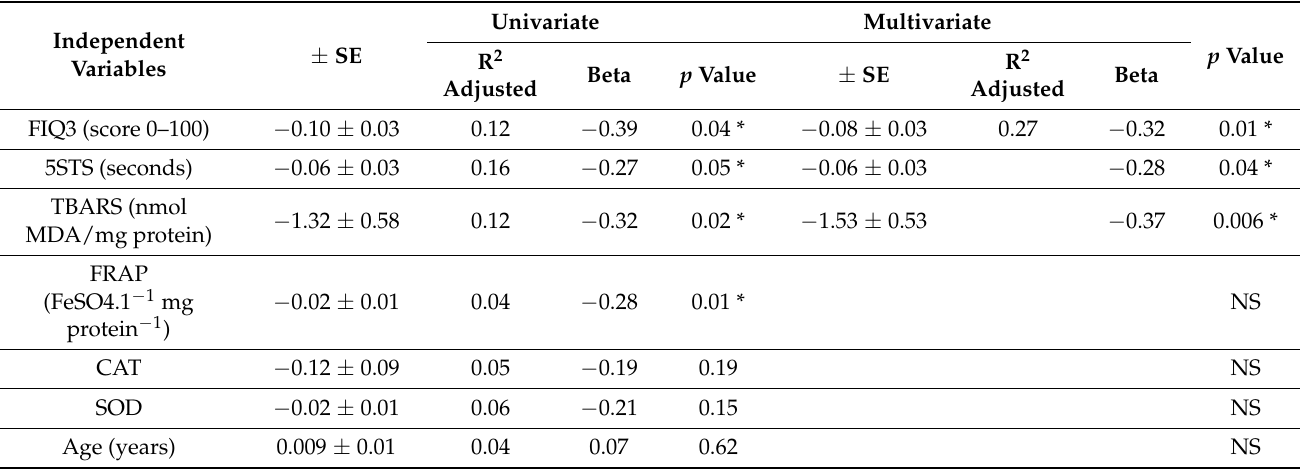
Table 3. Independent contributors to lean body mass in fibromyalgia patients ( n =